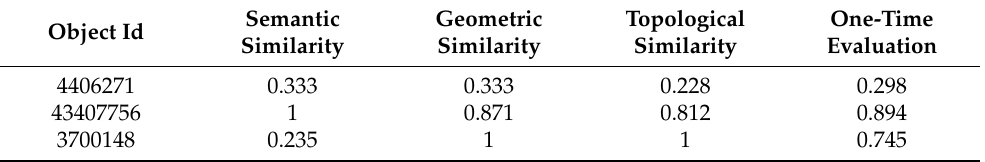
Table 4. Evaluation index score table of objects examples.